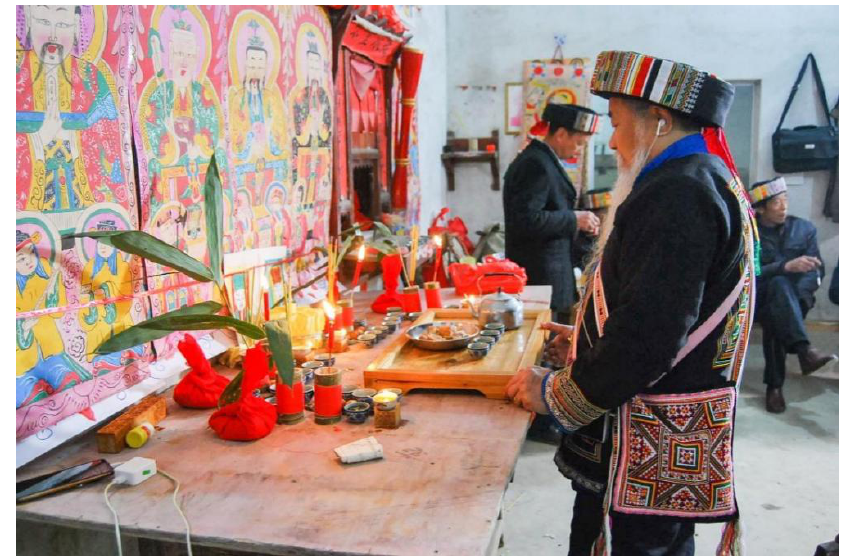
Figure 5. Greeting the sacred pallet .